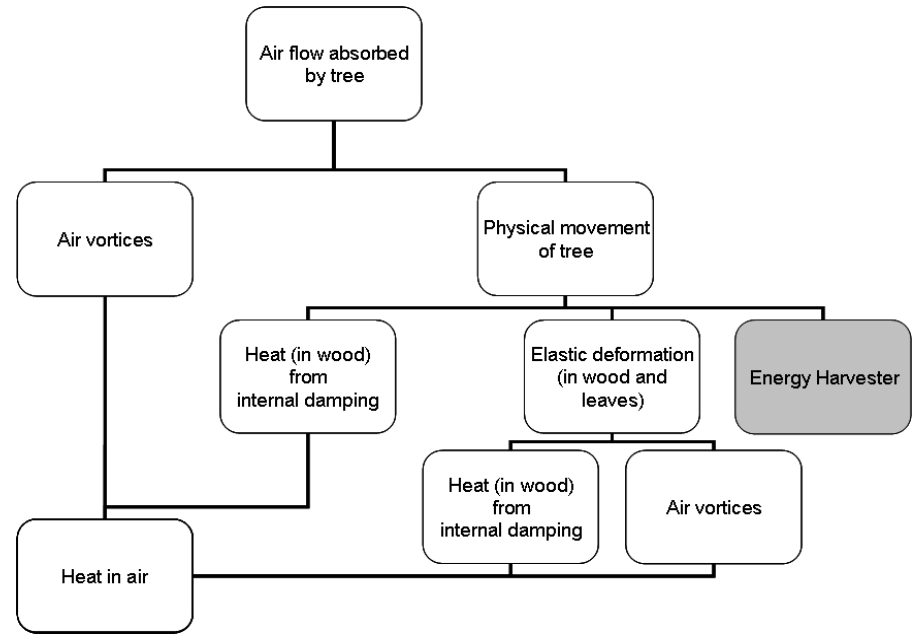
Figure 9. Wind power/energy dissipation